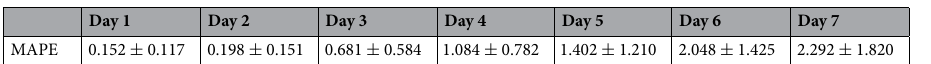
Table 1. Mean absolute percentage error (MAPE) between ground truth and predicted tumor cell densities over days for the test